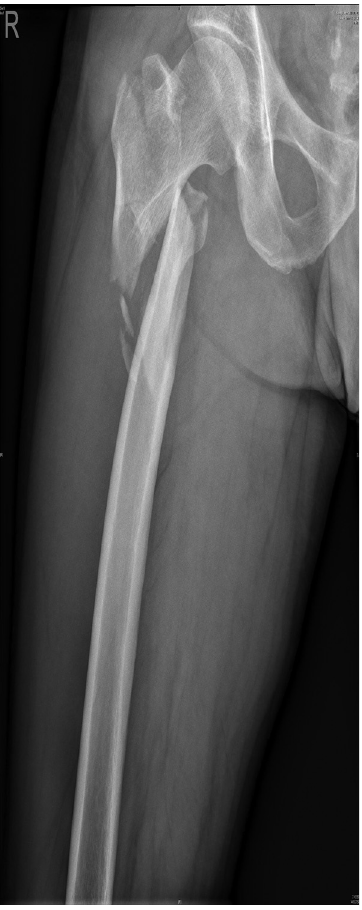
Figure 2: A 42 - year - old man fell from height and his X - ray exami - nation revealed that a femoral intertrochanteric fracture had occurred and that the fracture was